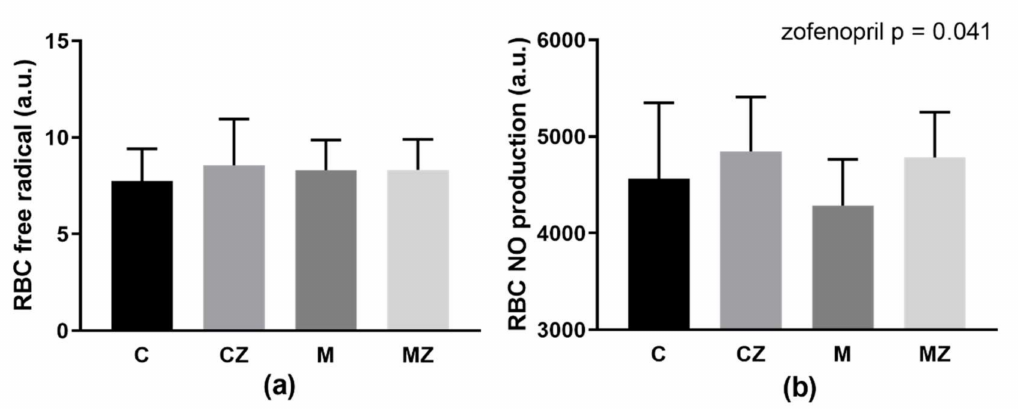
Figure 6. RBC free radical production ( a ) RBC-produced nitric oxide ( b ) Abbreviations: C—control group, CZ—zofenopril- treated group, M—MLN-treated (MLN-4760, ACE2 inhibitor) group, MZ—zofenopril and MLN-treated group, RBC—red blood cell, a.u.—arbitrary units, NO—nitric oxide. Data are presented as means ± standard deviations.